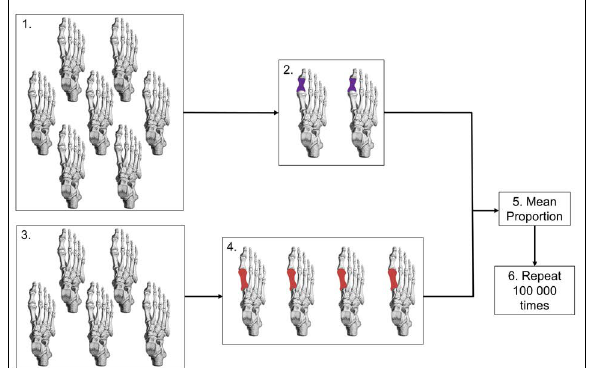
The resampling schematic for digit 1 if there is no association between the phalanges and the metatarsals. Step 1: Randomly sample 7 individuals from the sample of 110 modern humans.